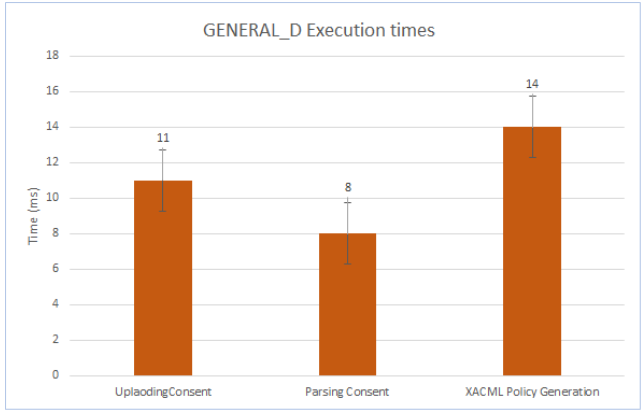
Figure 12. GENERAL_D Execution Time for Different